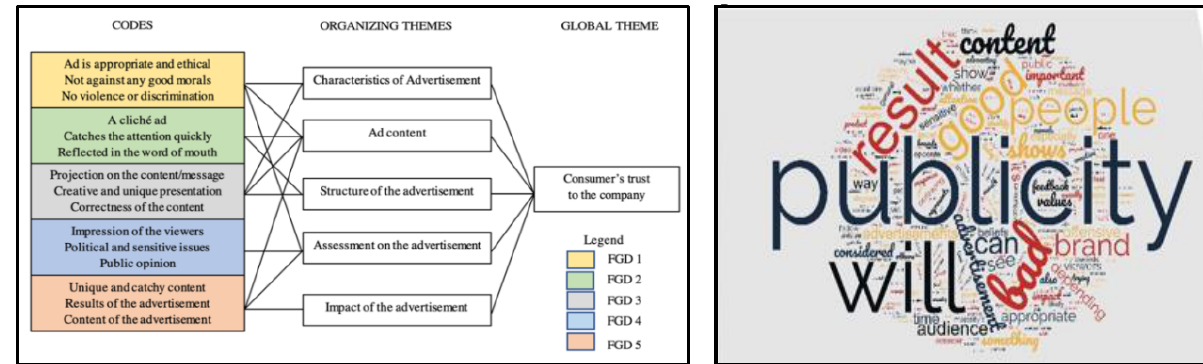
Figure 8: Broad View if an Advertisement Will Result in Good or Bad Publicity to The Brand it Represents